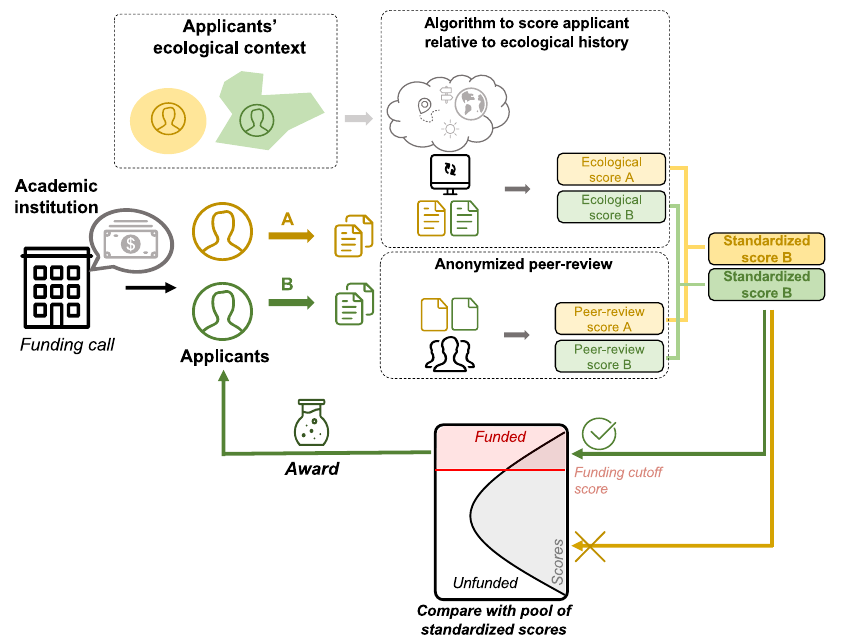
Fig. 1 Overview of the framework. A schematic example of the conceptual framework proposed here, in which academic institutions could implement a fair system to allocate academic capital amongst applicants (e.g., grants,